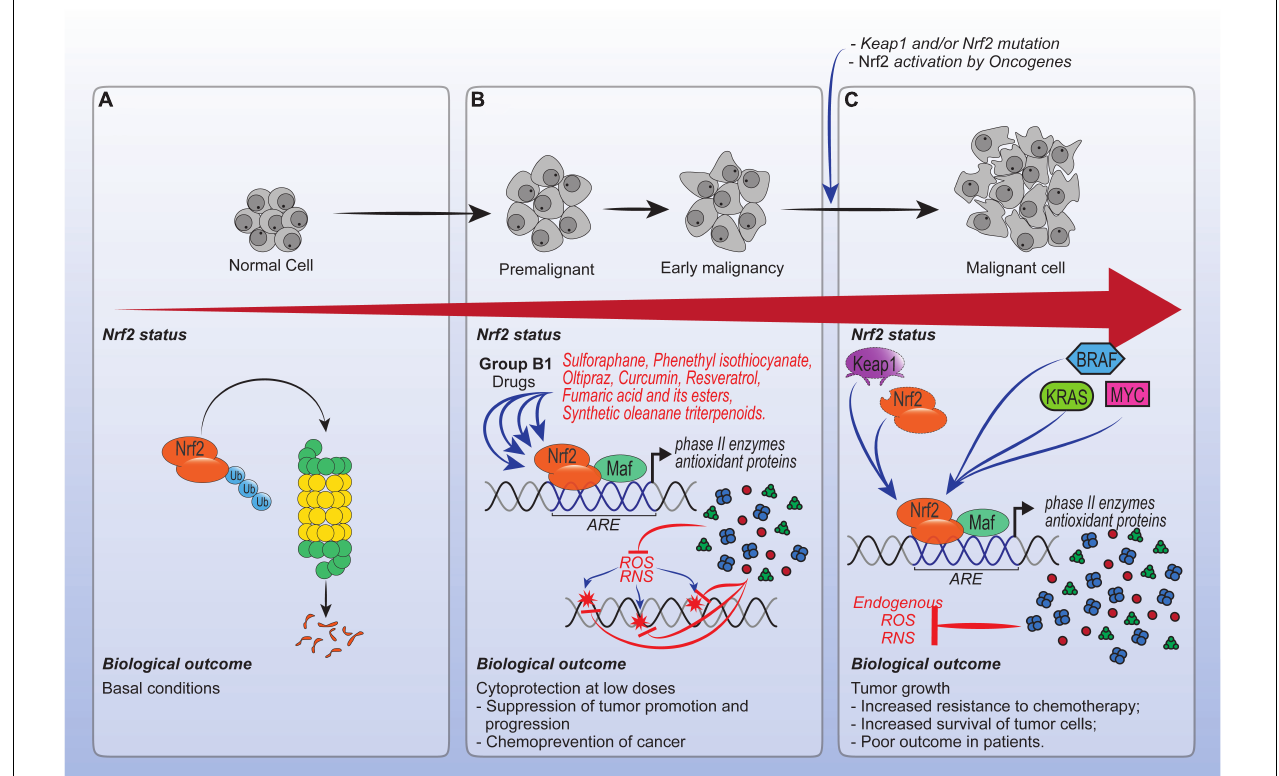
FIGURE 3 | Role of drugs acting via Nrf2 in cancer. (A) In normal cells, Nrf2 activity is regulated by canonical and non-canonical pathways, which in the absence of oxidative stress, culminate in Nrf2 proteossomal degradation. (B) Enhancing Nrf2 in premalignant and early malignant cells is important to prevent cancer development, specially by low doses of drugs capable of inducing phase II enzymes and antioxidant proteins expression. (C) Otherwise, in malignant cells the enhancement of Nrf2 activity caused by mutations such as Kras , Bras and Myc , can protect tumors from the cytotoxic effects of reactive oxygen species (ROS) induced by chemotherapy. However, the effects of drugs that act via Nrf2 at intermediate and chemotherapy stages still need investigation. Overall, the effects of Nrf2 in cancer depend on the biological development stage of tumor